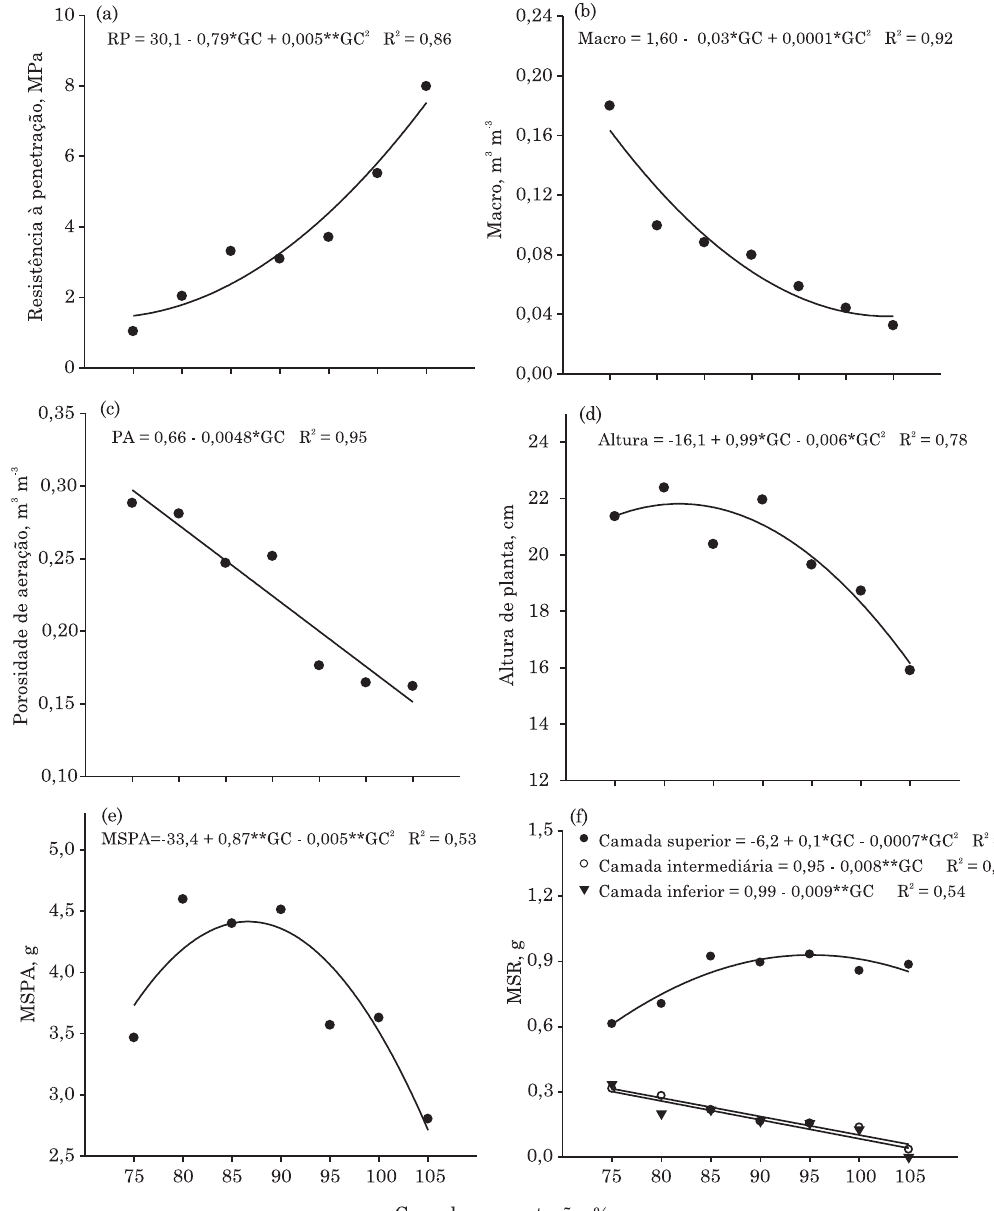
Figura 1. Resistência mecânica do solo à penetração - RP (a), macroporosidade - Macro (b), porosidade de aeração - PA (c), altura de plantas - Altura (d), massa de matéria seca da parte aérea - MSPA (e), massa de matéria seca da raiz (MSR) nas camadas superior, intermediária e inferior (f) em diferentes graus de compactação de um Latossolo Bruno. * e **: significativos a 5 e 1 %,